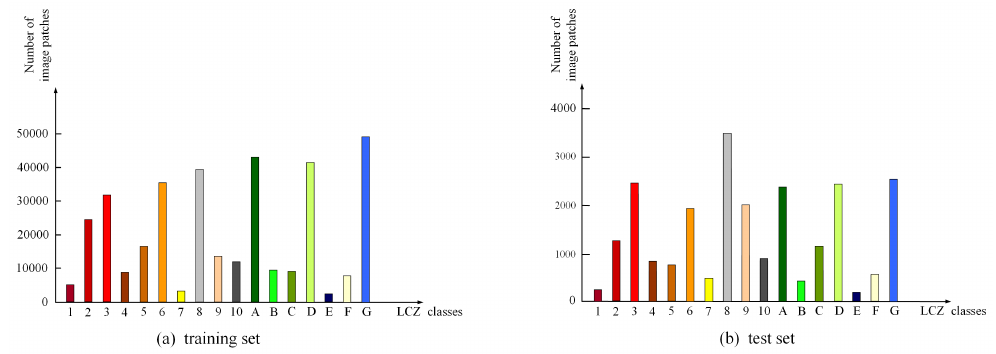
Figure 6. Sample distribution of LCZ labels in training set ( a ) and test set ( b